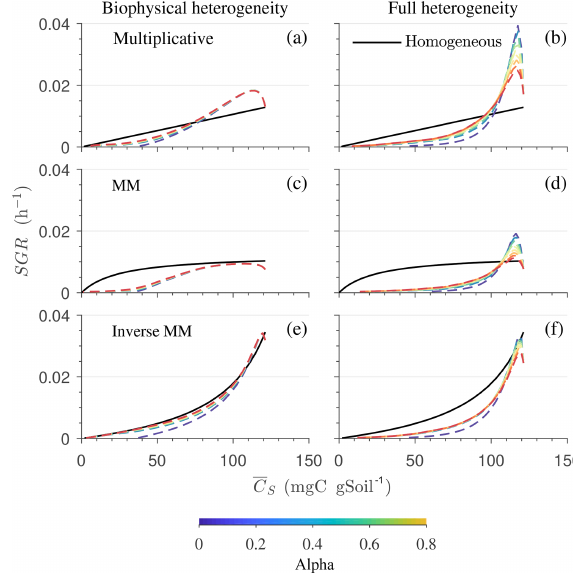
Figure 9. Effect of spatial heterogeneity on the mean specific growth rate (SGR) for the HS scenario including C redistribution: effect of biophysical (a, c, e) and full (b, d, f) heterogeneity on the mean SGR as a function of mean substrate C ( C s ) for an uncorre- lated initial distribution of substrates and microorganisms. The three horizontal panels are for (a, b) multiplicative, (c, d) Michaelis– Menten, and (e, f) inverse Michaelis–Menten kinetics. Different col- ors represent varying values of α . Time progresses from right to left as C s is